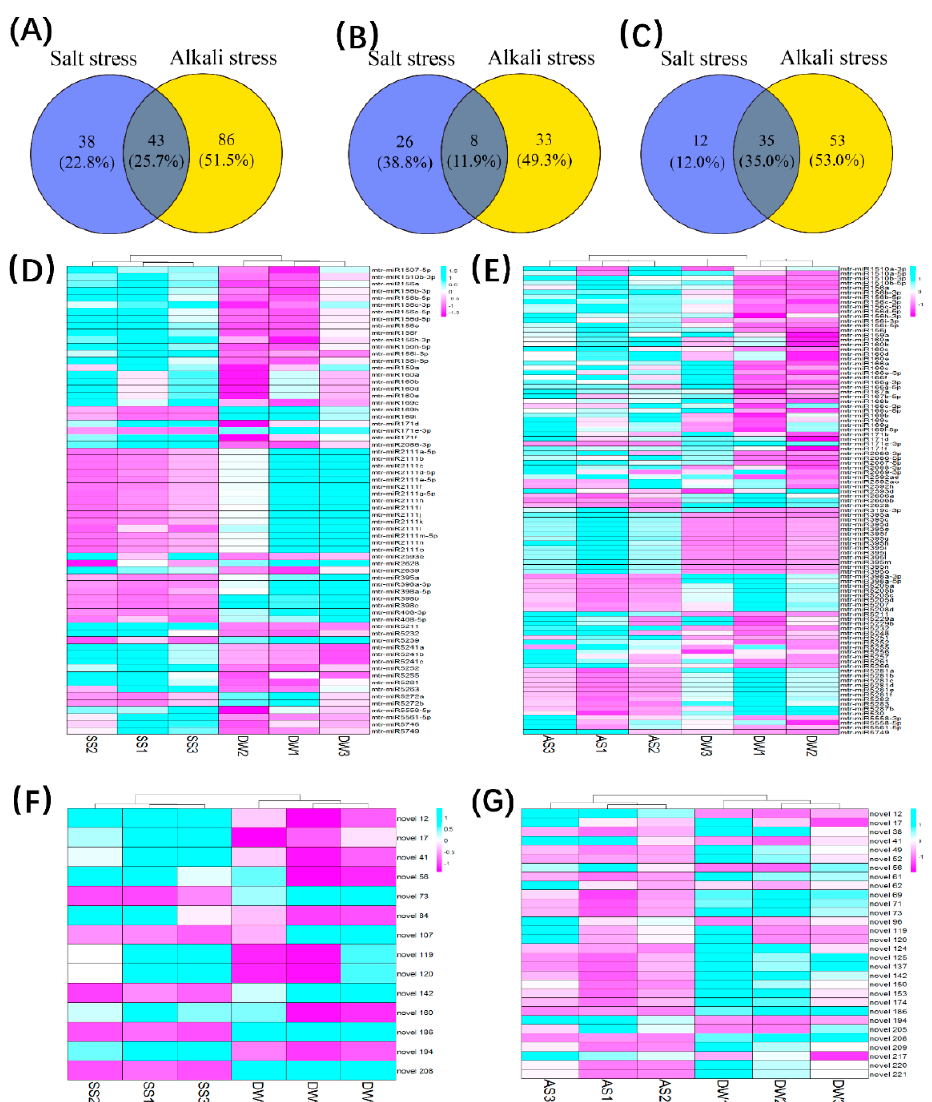
Figure 4. Differentially expressed miRNAs in salt and alkali stress during the germination of R108. Fold change values greater than 1.5 or less than 0.67 indicate upregulated or downregulated miRNAs. ( A – C ) The Venn diagram of the common and specific miRNAs differentially expressed miRNAs in salt stress and alkali stress. A , total differently expressed miRNAs; B , down-regulated miRNAs only; C , up-regulated miRNAs; ( D , E ) The expression patterns and hierarchal clustering of differentially expressed known miRNAs in salt and alkali stress, respectively; ( F , G ) The expression patterns and hierarchal clustering of differentially expressed putative miRNAs in salt and alkali stress.